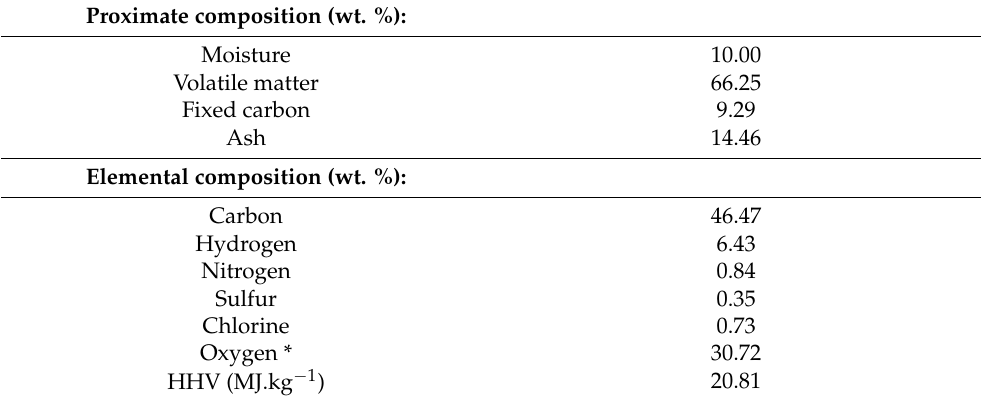
Table 1. Proximate and elemental composition and calorific value of RDF. Proximate composition (wt.